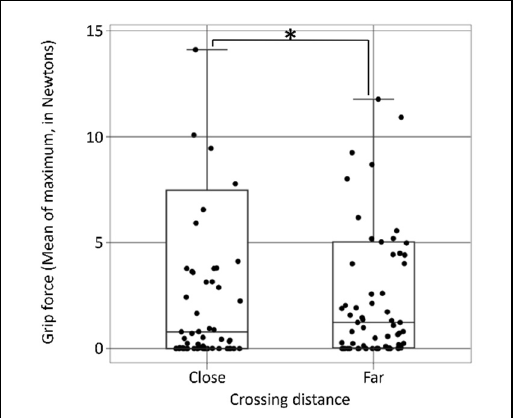
Figure 9. Grip force (window calculation: mean, single measurement event calculation for all 60 sensors; maximum in Newtons) as a function of the crossing distance. Boxes represent the inter- quartile range (IQR = Q1 to Q3) of the group, middle horizontal line represents the group’s median, upper line represents the largest value that is less than the upper quartile plus 1.5 times IQR, and lower line represents the smallest value that is greater than the lower quartile minus 1.5 times IQR. Asterisk (*) denotes a level of significance of p < 0.05.